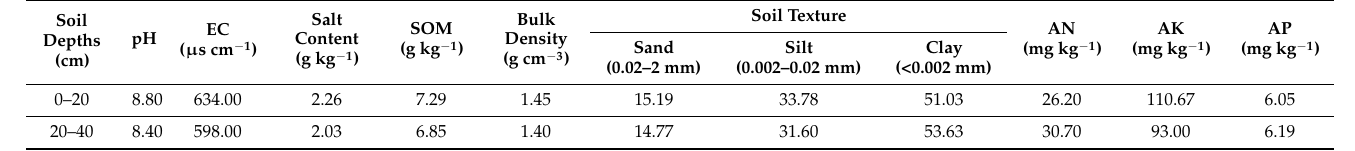
Table 1. Basic soil properties of the study area.